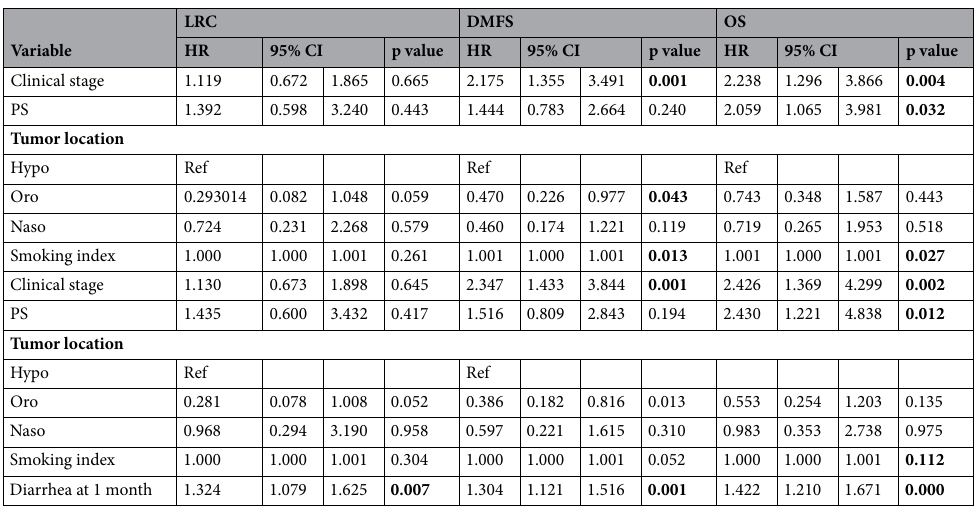
Table 4. Multivariate analysis of clincal variables and diahhrea for LRC and OS. Abbreviations are the same as in Table 2. Significant values are in